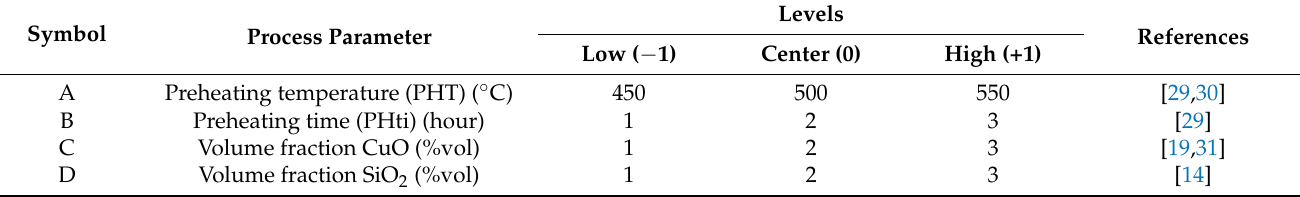
Table 2. Factors considered in the design of experiment and associated